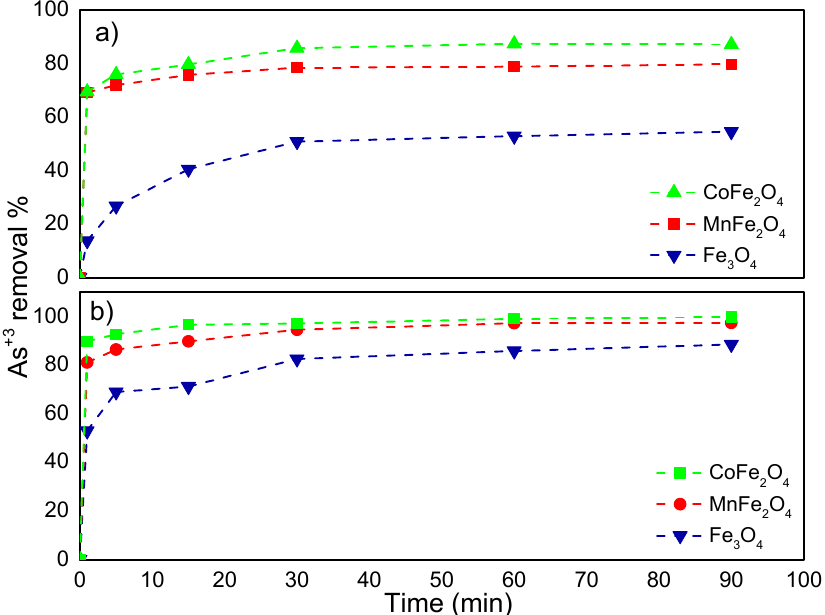
Figure 3. As groundwater removal (%) with the three nanoparticles (CoFe 2 O 4 , MnFe 2 O 4 , and Fe 3 O 4 ) at different adsorbent doses ( a ) 0.01 g/L and ( b ) 0.1 g/L.